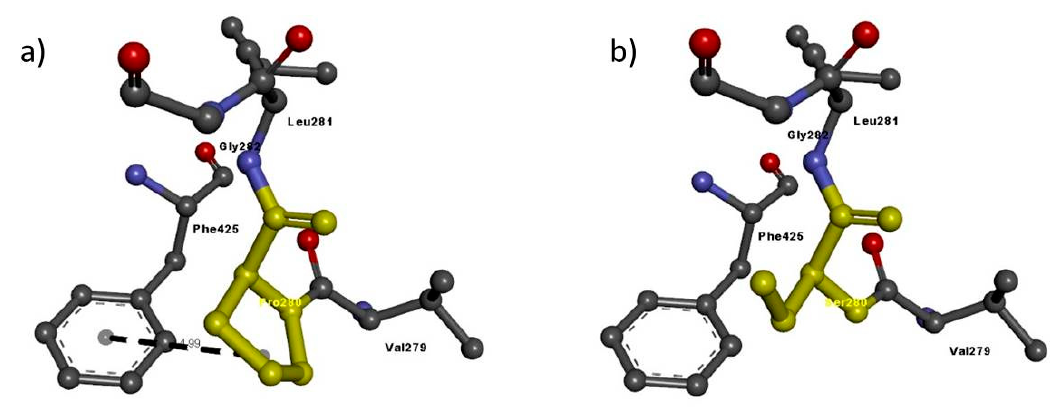
Figure 8. Molecular interactions of ( a ) Pro280 and ( b ) Ser280 (in yellow) of the modeled NRP2 protein with adjacent residues.